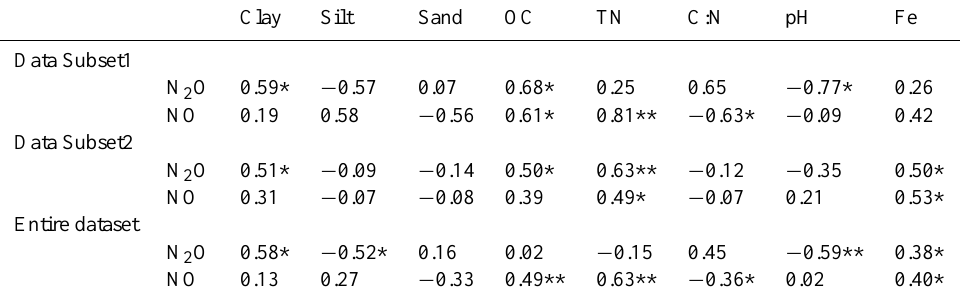
Table 2. Correlation coefficients for N 2 O and NO emission rates and soil properties (silt and clay content; organic carbon (OC), total nitrogen (TN), C:N ratio pH, and free iron (Fe)) for two different data subsets data subset 1: locations at high altitude and micaschists as dominant parent material; and data subset 2: locations at low altitude and schists as dominant parent material. In this analysis we only include N oxide emission data from the 50% WFPS; **indicates significant correlations at P < 0 . 01 and *indicates significant correlations at P < 0 . 05. Clay Silt Sand OC TN C:N pH Fe Data Subset1 N 2 O 0.59* − 0.57 0.07 0.68* 0.25 0.65 − 0.77* 0.26 NO 0.19 0.58 − 0.56 0.61* 0.81** − 0.63* Data Subset2 N 2 O 0.51* − 0.09 − 0.14 NO 0.31 − 0.07 − 0.08